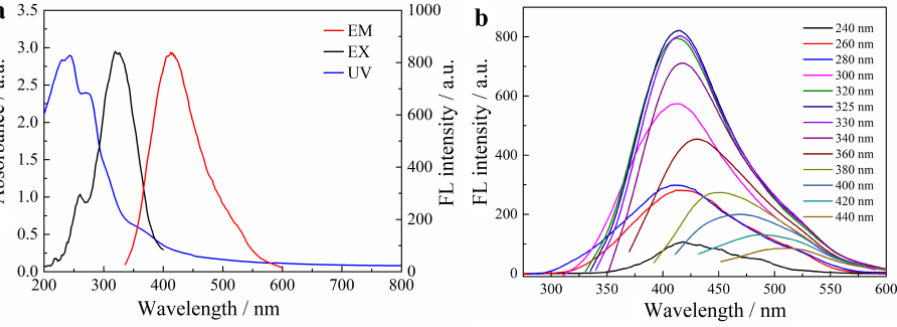
Figure 2. ( a ) The UV-vis absorption spectra, FL excitation and emission spectra of C SM -dots. ( b ) The FL emission spectra of C SM -dots under different excitation wavelengths.